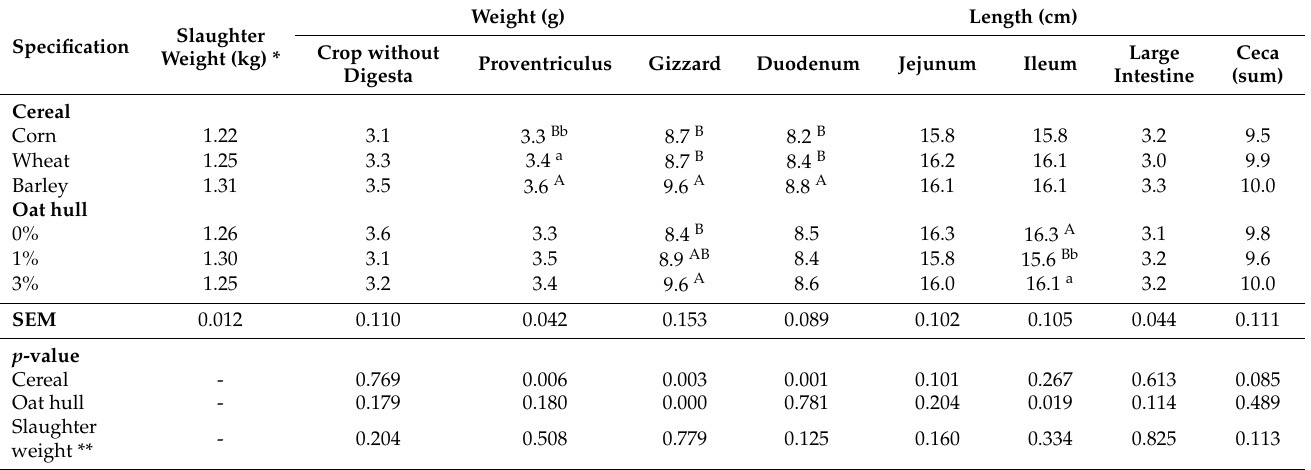
Table 6. Metabolic weight of organs and lengths of intestines recalculated for metabolic weight (BW 0.67 ) in broiler chickens ( n =